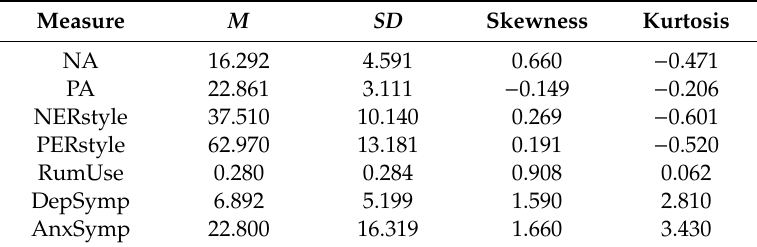
Table 1. Preliminary descriptive